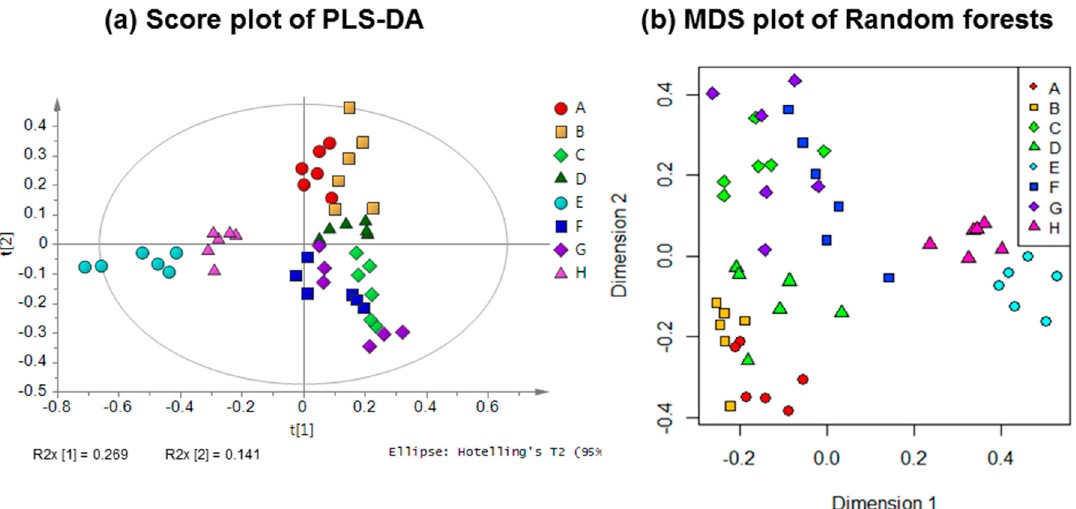
Figure 2. ( a ) PLS-DA score plot and ( b ) Random Forests multidimensional scaling (MDS) plot for A. malaccensis gaharu samples of different grades.